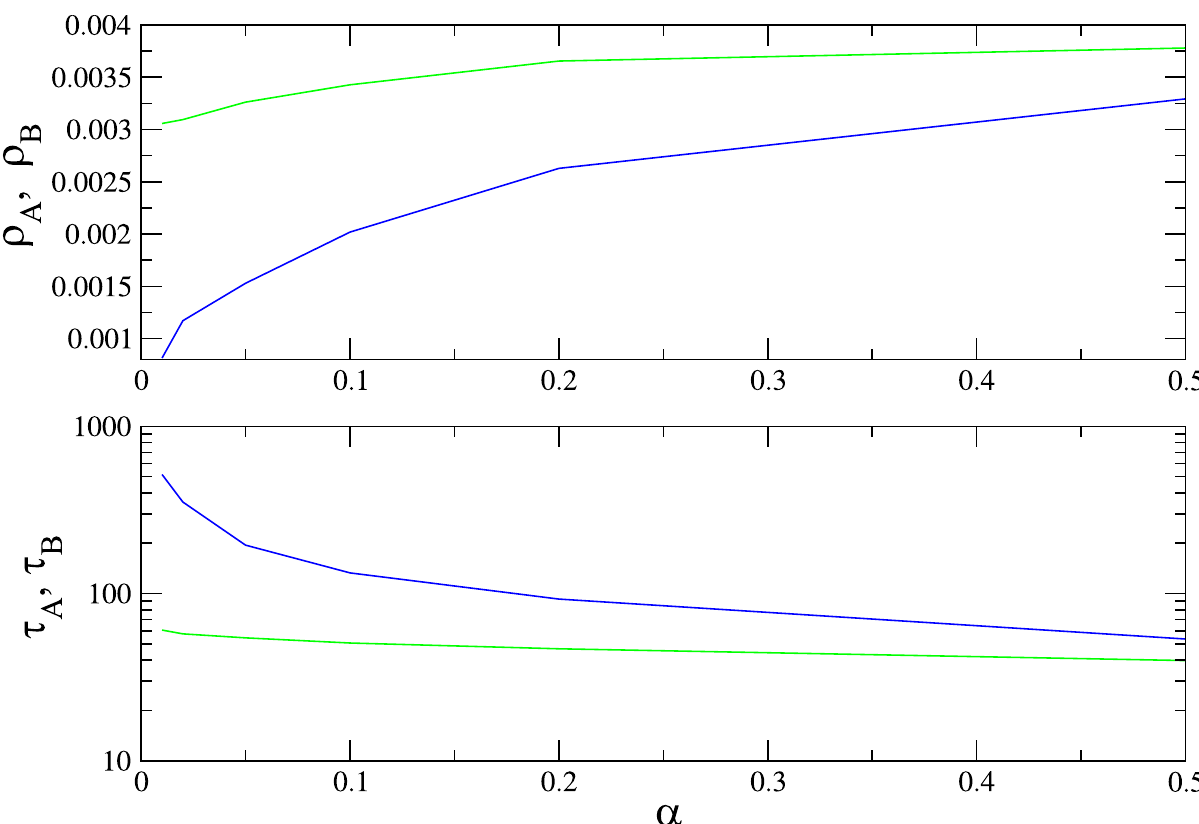
Fig 14. (Color online) Square lattice: QS population densities (upper panel) of species A and B and lifetime of the QS state (lower panel) for λ = 1.65 and linear systemsize L = 80.